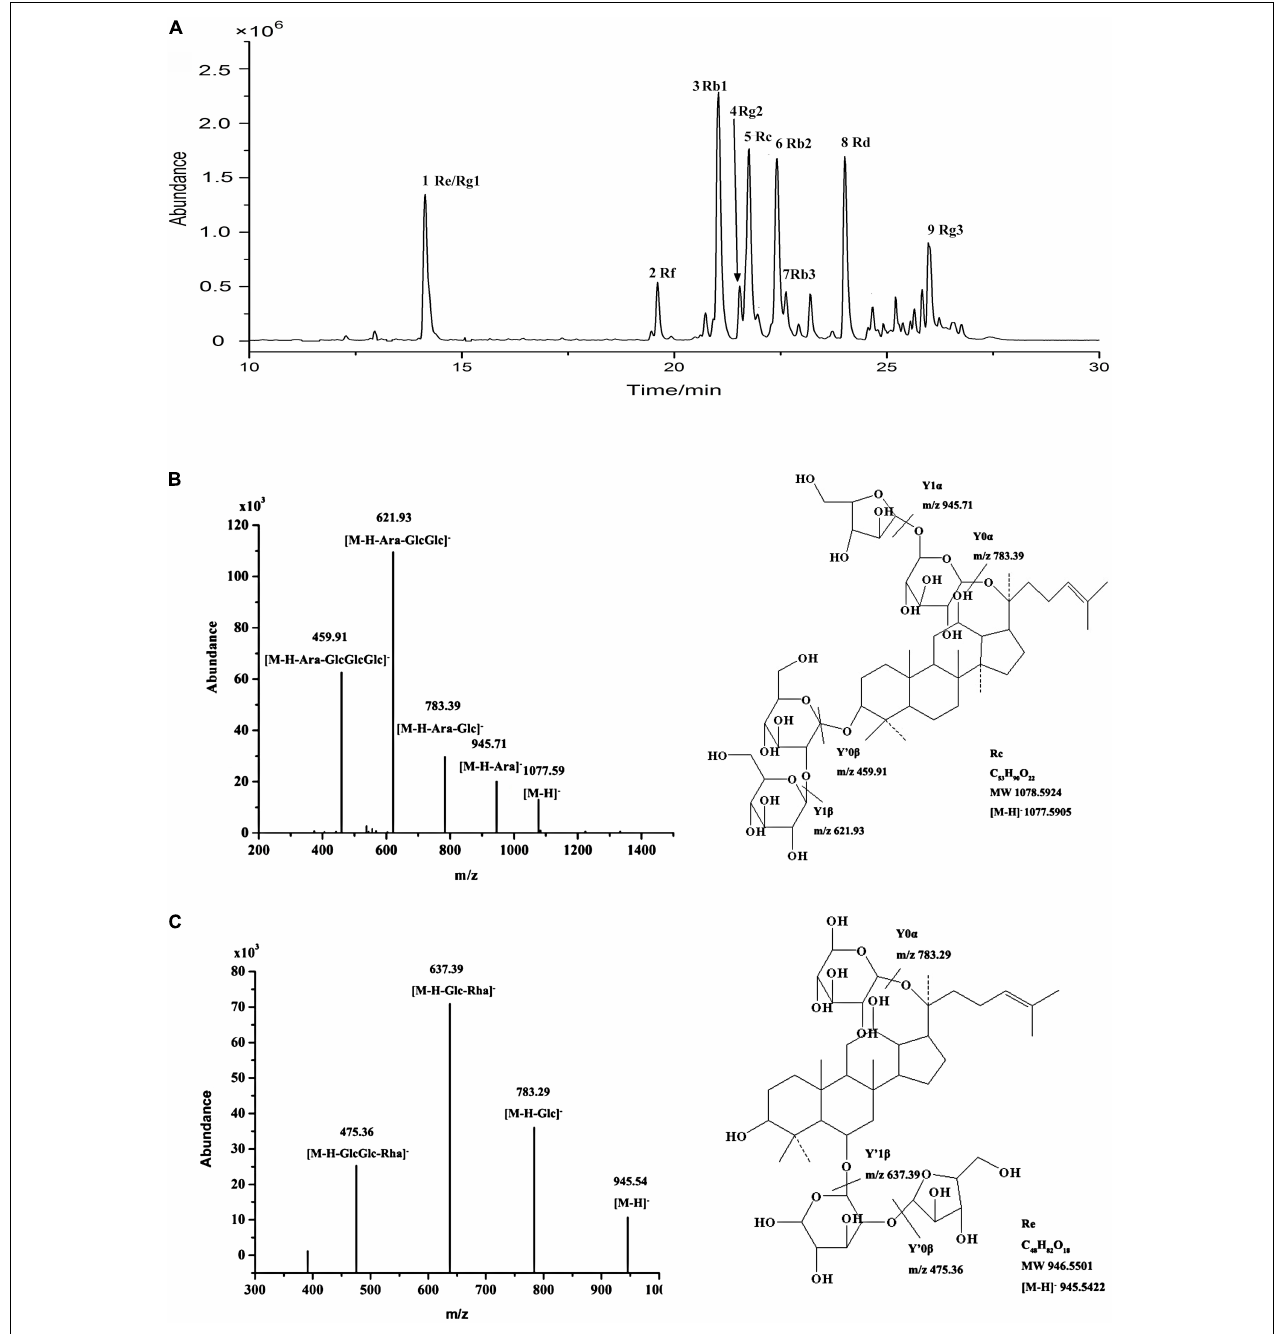
FIGURE 1 | (A) UHPLC-Q-TOF-MS TIC of total ginsenoside of red ginseng. (B) ESI-Q-TOF-MS/MS spectra of ginsenoside Rc in negative ion mode. (C) ESI-Q-TOF-MS/MS spectra of ginsenoside Re in negative ion mode.